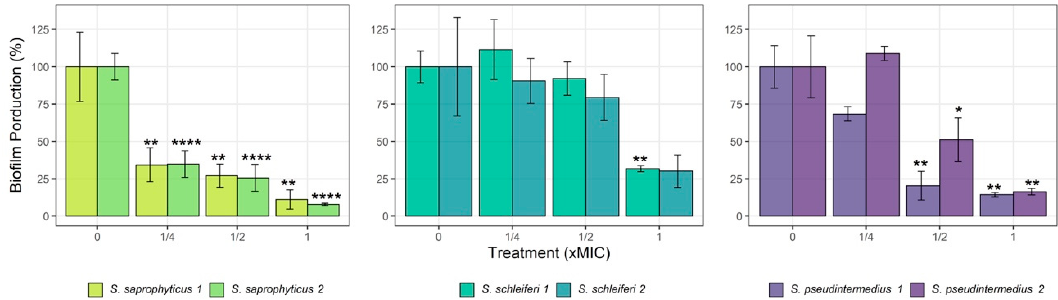
Figure 2. Percentage of inhibition of Staphylococcus biofilm formation growth simultaneously with sub-inhibitory concentration (¼-, ½- and 1-fold of MIC) of Cinnamomum zeylanicum essential oil (CZEO) during 24 h. Statistically different by one-way ANOVA with Tukey post hoc test (* p < 0.05, ** p < 0.01; **** p < 0.0001) compared to untreated cells.